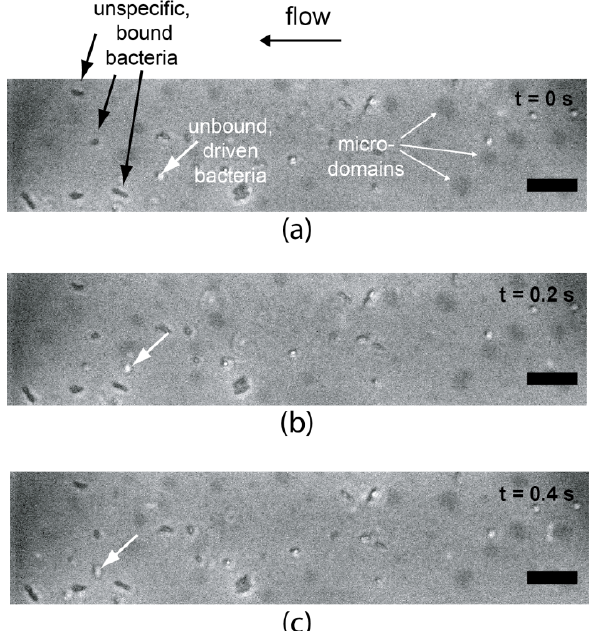
Figure 9. Overlay of phase contrast and fluorescence images of E. Coli HB101 on a supported membrane displaying FL10man domains (black patches) under a shear rate of 2.7 s − 1 . The scale bars are 25